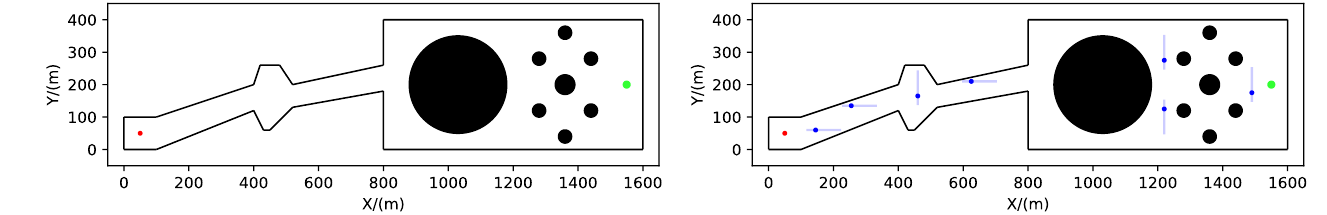
Figure 7. Test environment. ( a ) Static environment. ( b ) Dynamic environment. • : AUV; • : Goal; (cid:4) : Obstacle; • : Dynamic obstacle; —: Dynamic obstacle